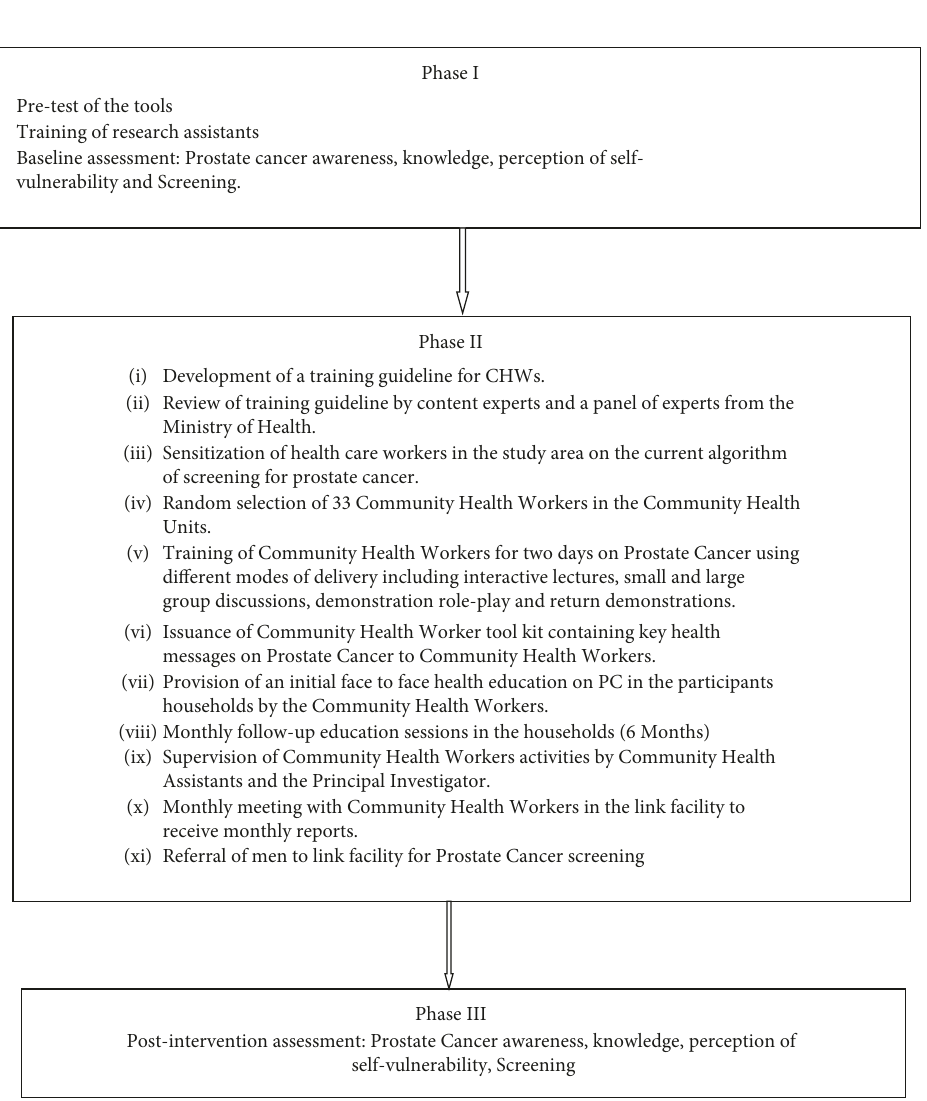
Figure 2: Diagrammatic representation of the community-based health education intervention. Table 2: Sociodemographic